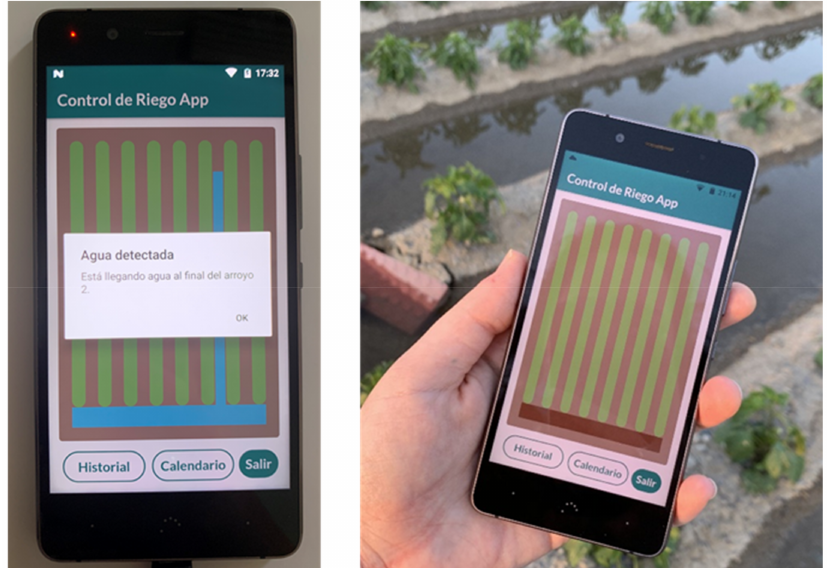
Figure 26. Execution of application in the